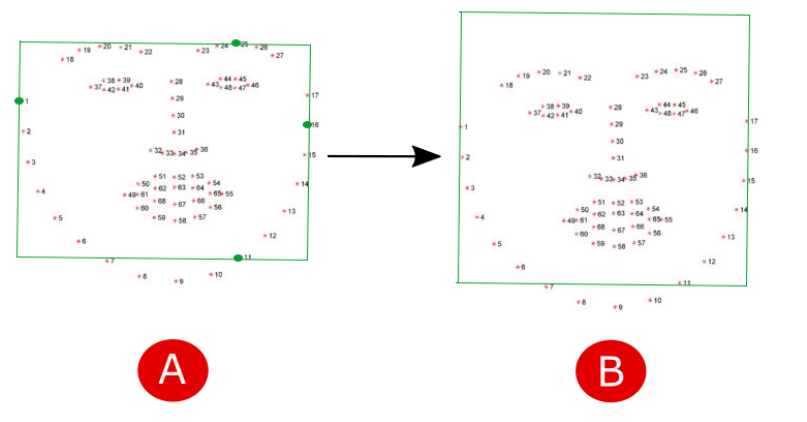
Figure 4. Computation of the bounding box including ( A ) the face and ( B ) the